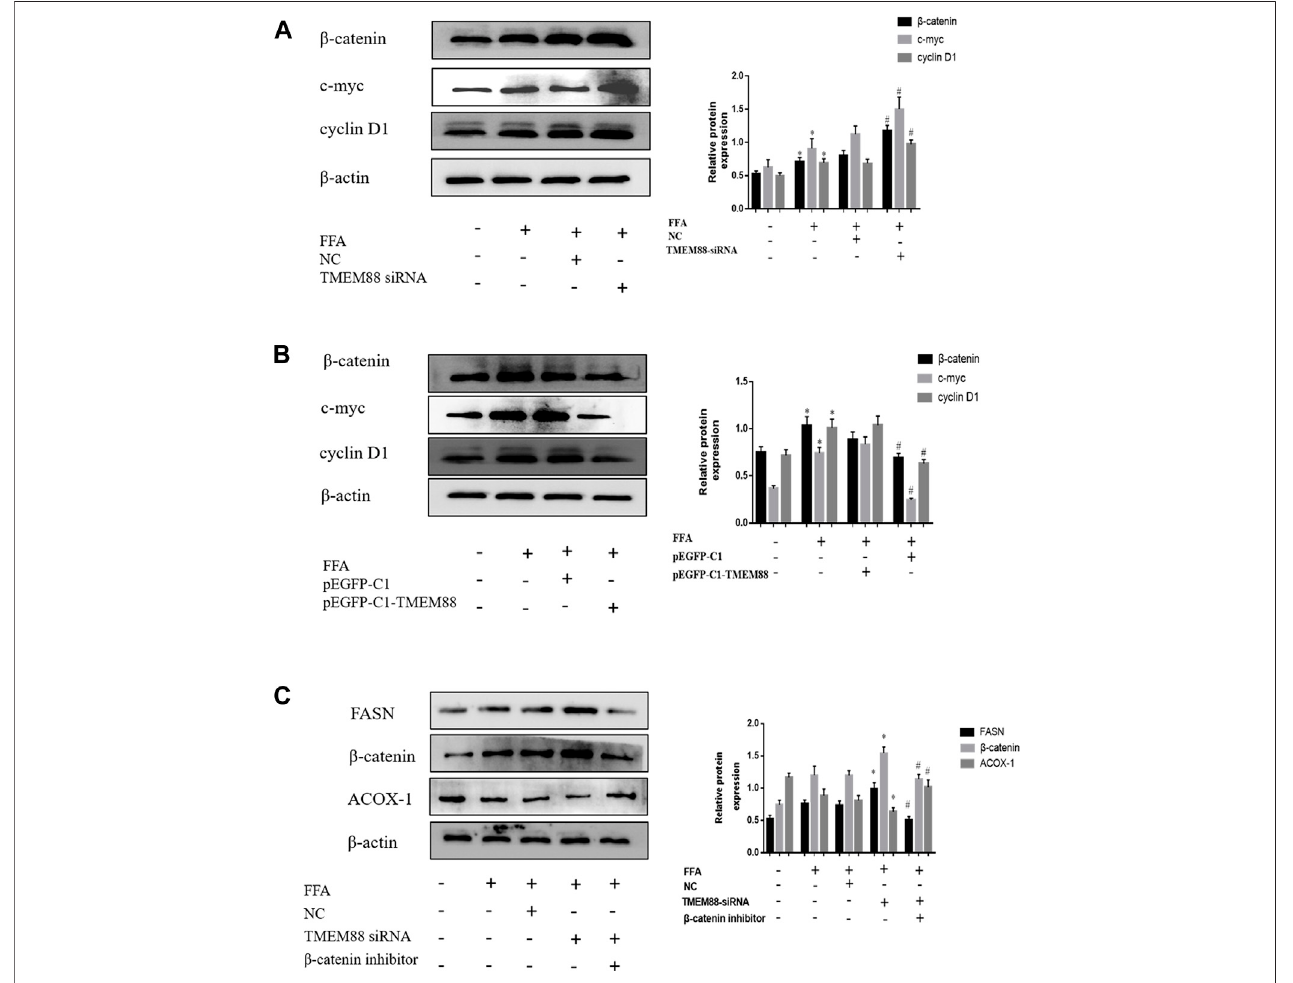
FIGURE 8 | Expression of β -catenin and related signaling pathways in FFA-induced AML-12 cells. (A,B) The Wnt/ β -catenin, c-myc, and cyclin D1 signaling pathways were elevated in FFA-induced AML-12 cells. (C) The downregulated of β -catenin can promote lipid metabolism. (The data are represented by at least three independent mean ± SD, * p < 0.05 vs control group, # p < 0.05 vs siRNA+ β -catenin inhibitor